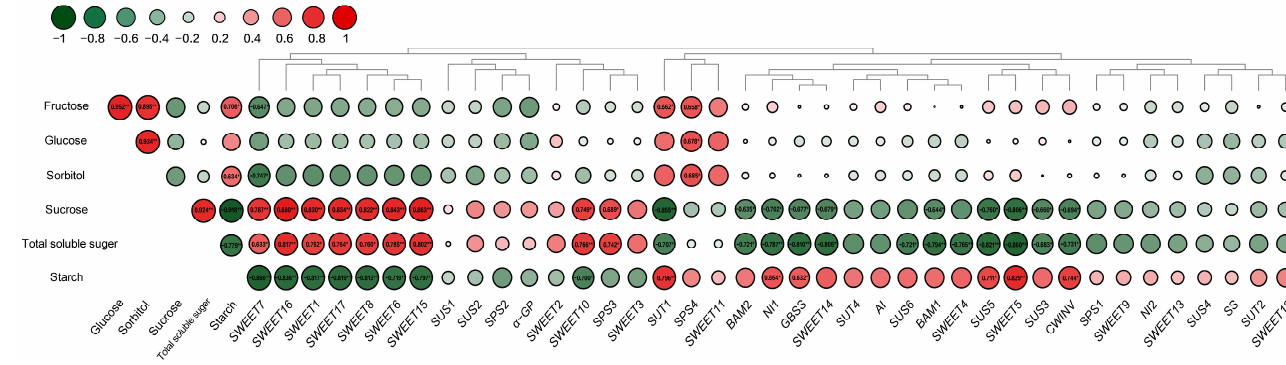
Figure 6. Correlation analysis between expressions of the sugar-related genes and the sugar content in nectarine. The circular bubble sizes represent the correlation coefficient from low to high. The color gradient from green to red corresponds to correlation coefficient changes from negative to positive. The value in the bubble is the correlation coefficient. * indicate the differences significant. (* p < 0.05, ** p < 0.01).